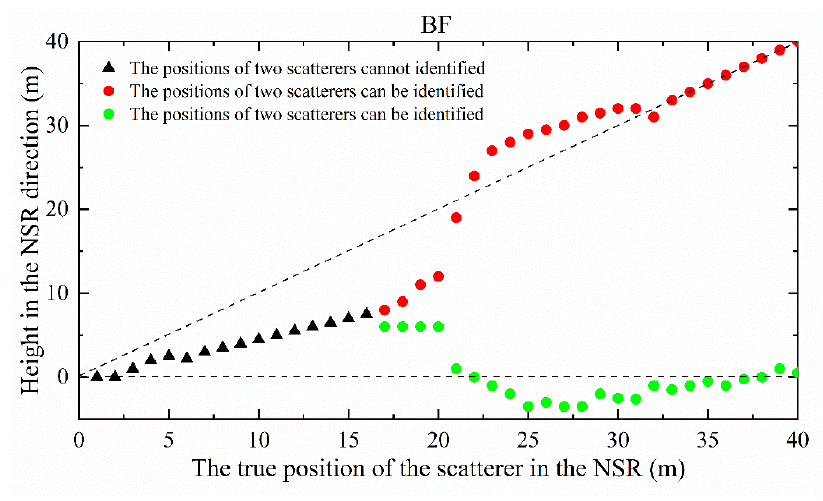
Figure 6. Simulation results of NSR resolution for BF.